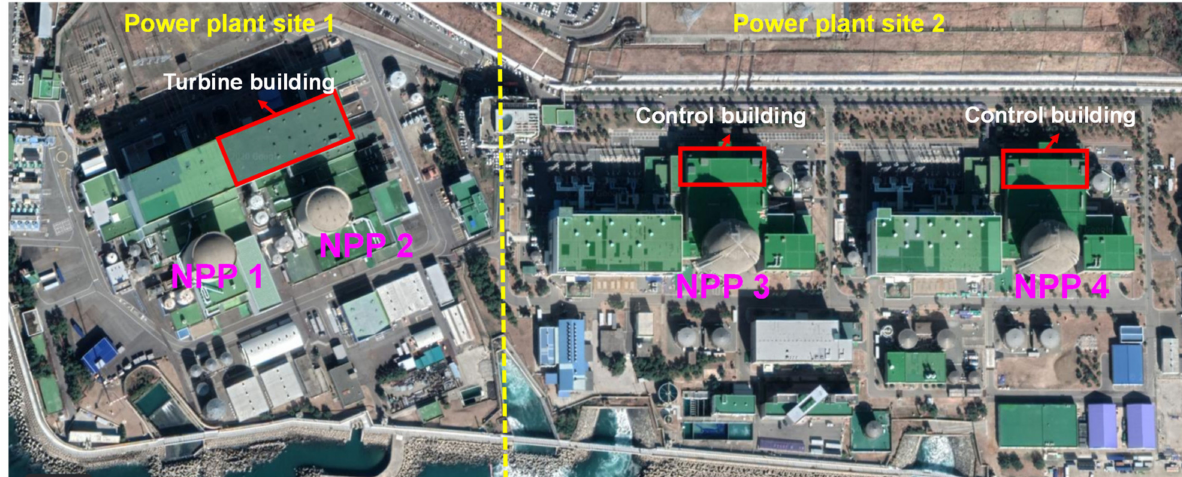
Figure 1. Flood areas (red boxes) selected for the NPP sites (Google Maps